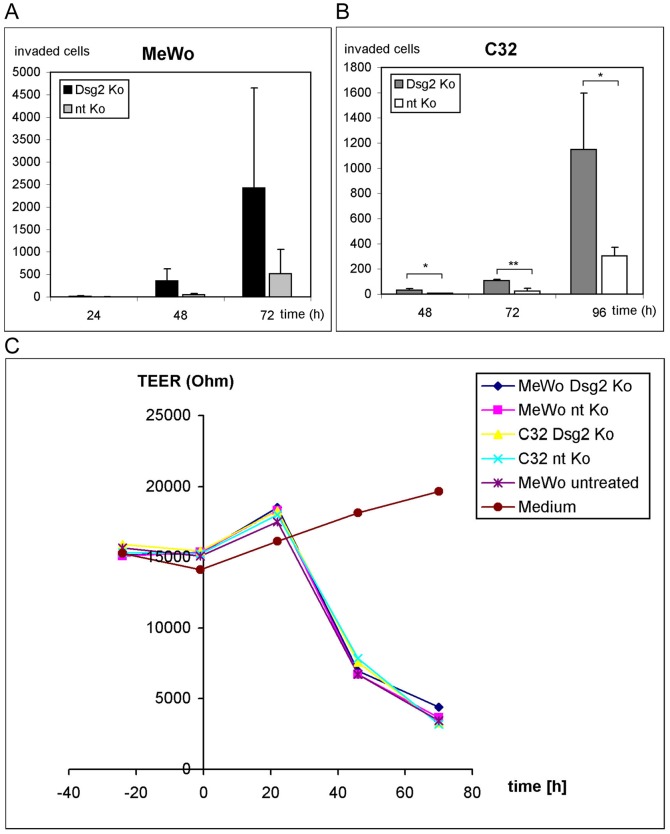
Impact of Dsg2 on invasion.(A, B) Transwell invasion assays of Dsg2-depleted (“Dsg2 Ko”) or non-targeting siRNA-treated (“nt Ko”) MeWo and C32. Considerably more Dsg2 Ko than nt Ko MeWo had invaded after 24, 48 and 72 h (A); however, differences did not achieve significance. (B) In the line C32, the number of invaded cells was significantly increased upon Dsg2 knockdown after 48, 72 and 96 h. Bars: SD; * p≤0.05, ** p≤0.01. (C) TEER assay, showing no alteration of invasive properties upon Dsg2 depletion. A marked decrease in TEER was seen in cocultures of Dsg2 Ko, nt Ko or untreated MeWo and C32 with a MDCK-C7 monolayer after 48 and 72 h. However, no significant differences were noted between Dsg2-depleted and control cells.